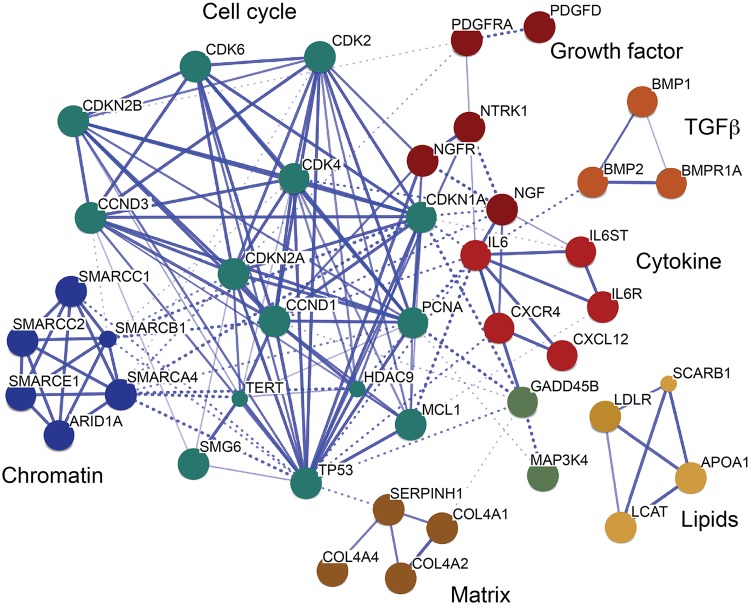
A CAD gene network identified among TCF21 target genes.Genes in CAD-associated loci that have TCF21 peaks identified by ChIP-Seq were assembled into a network, with incorporation of additional non-associated genes to promote the connectivity shown here. This transcriptional network was created by STRING [35]. Many additional CAD genes downstream of TCF21 were not incorporated into the network, due to an overall lack of functional annotation for these loci.